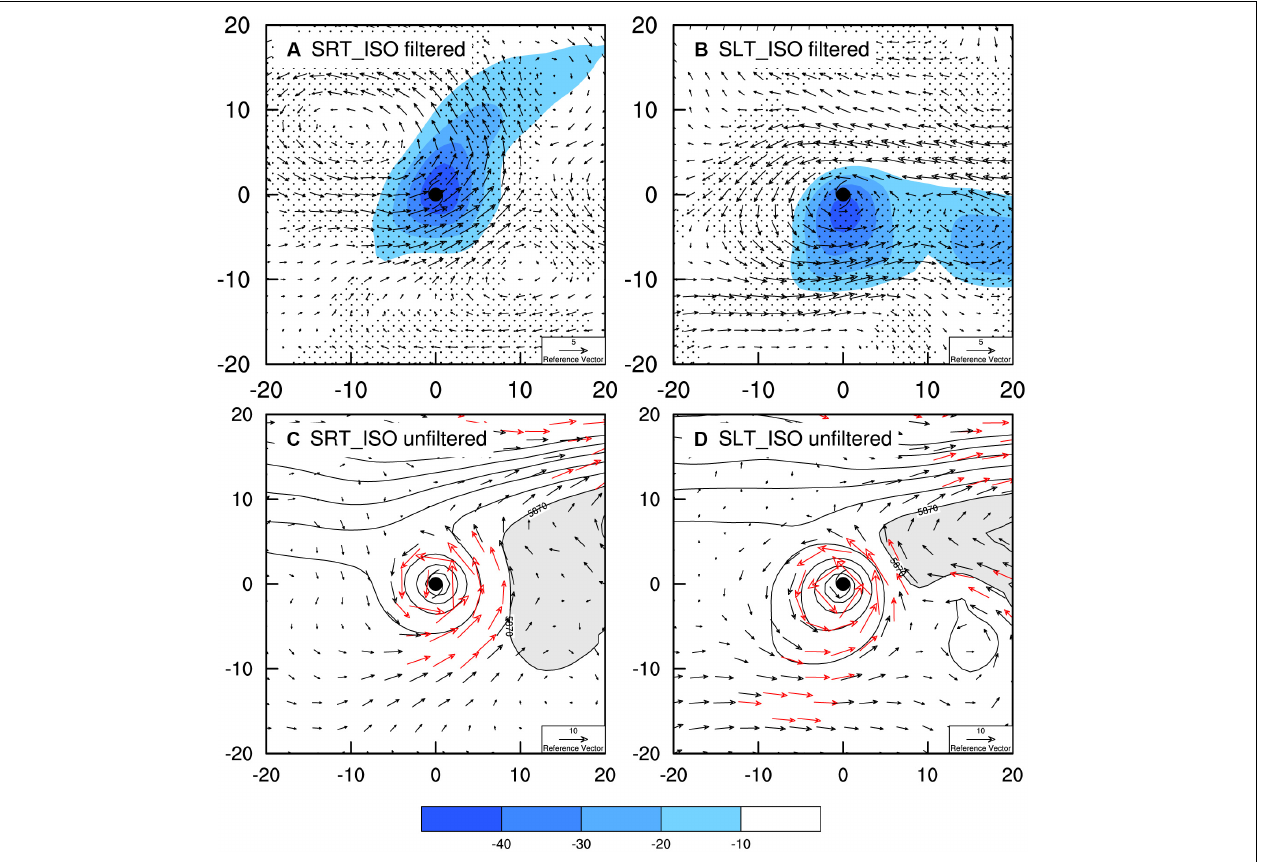
FIGURE 8 | (A,B) The composite filtered deep-layer averaged winds (vector, m s − 1 ) with the dotted area exceeding 95% significance, overlaid by the corresponding OLR field (shaded, W m − 2 ) and (C,D) unfiltered 700-hPa winds (vector, m s − 1 ), and 500-hPa geopotential height (contour, gpm) for the R1090 and L1090 cases at the turning time respectively. Red vectors in (C) and (D) represent wind speeds larger than 8 m s − 1 and areas more than 5870 (gpm) in (C) and (D) are shaded. The coordinates are the latitudes and longitudes based on TC